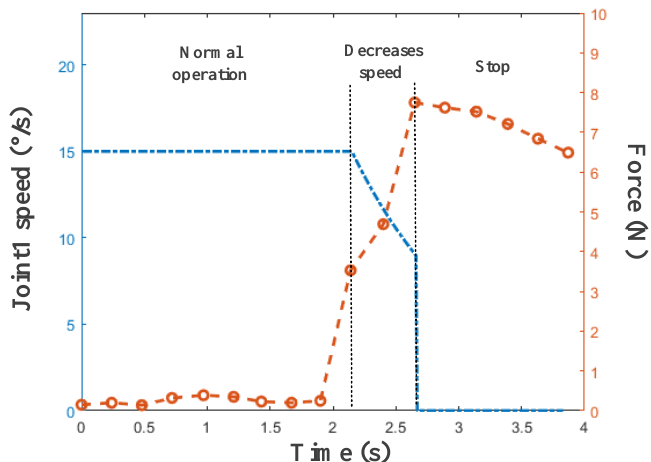
Figure 11. The speed of Joint 1 in the robot arm (blue curve) and the maximum force of the sensor array (red curve) during the human–robot interaction experiments.